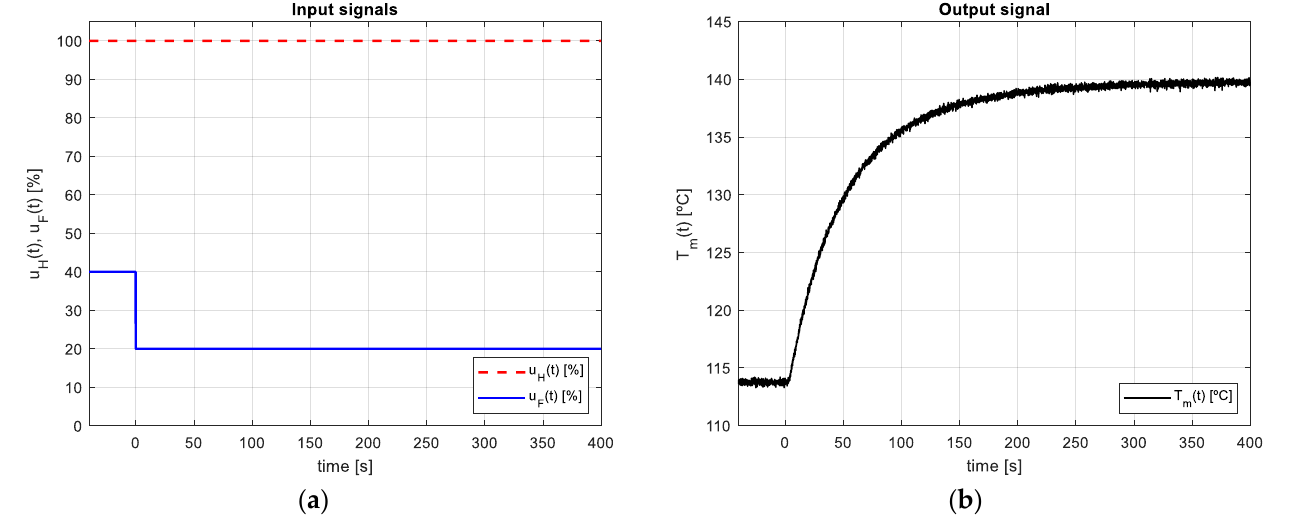
Figure 13. Experimental data obtained from a step test for identification of the process model in the controlled process configuration #2: ( a ) Control signal u F (t) [%] and command signal to heating re-